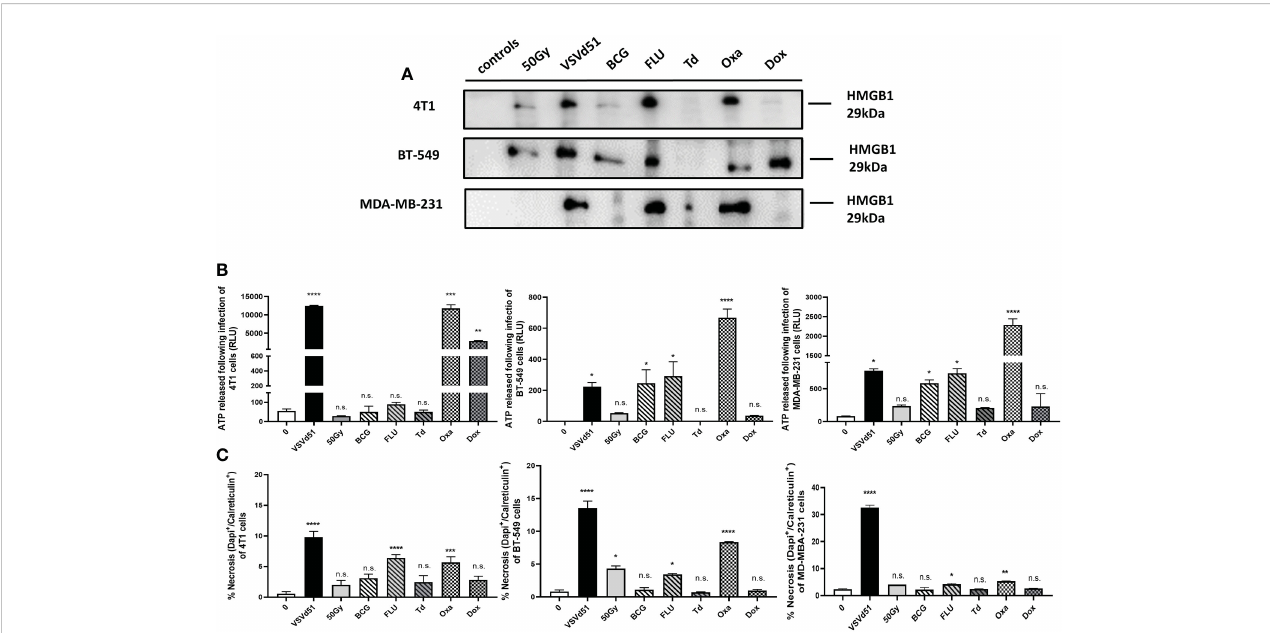
FIGURE 1 Immunogenic cell death of mouse and human TNBC cells can be induced following in vitro treatment with the chemotherapeutic agent oxaliplatin and the season in fl uenza vaccine. (A) Western blot analysis of HMGB1 from cell-free supernatants, (B) luminometry measurement of relative ATP from cell- free supernatants, and (C) measurement of cell surface calreticulin of TNBC cell lines treated with ICD inducers at their IC50 concentrations or infected with VSVd51 at 10 MOI for 24h. The results were compared to non-treated cells. All data are representative of at least three similar experiments where n=3 for technical replicates, *P < 0.05; **P < 0.01; ***P < 0.001; ****P < 0.0001; (n.s., no signi fi